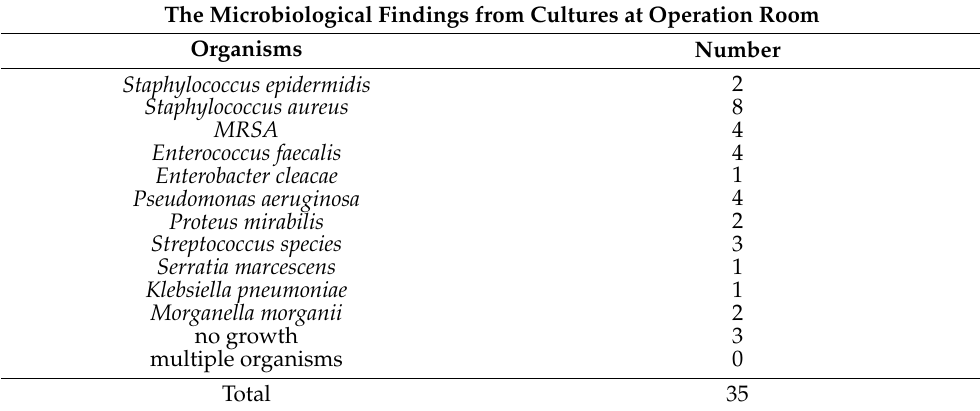
Table 2. Microbiological results from cultures proceeded at operation